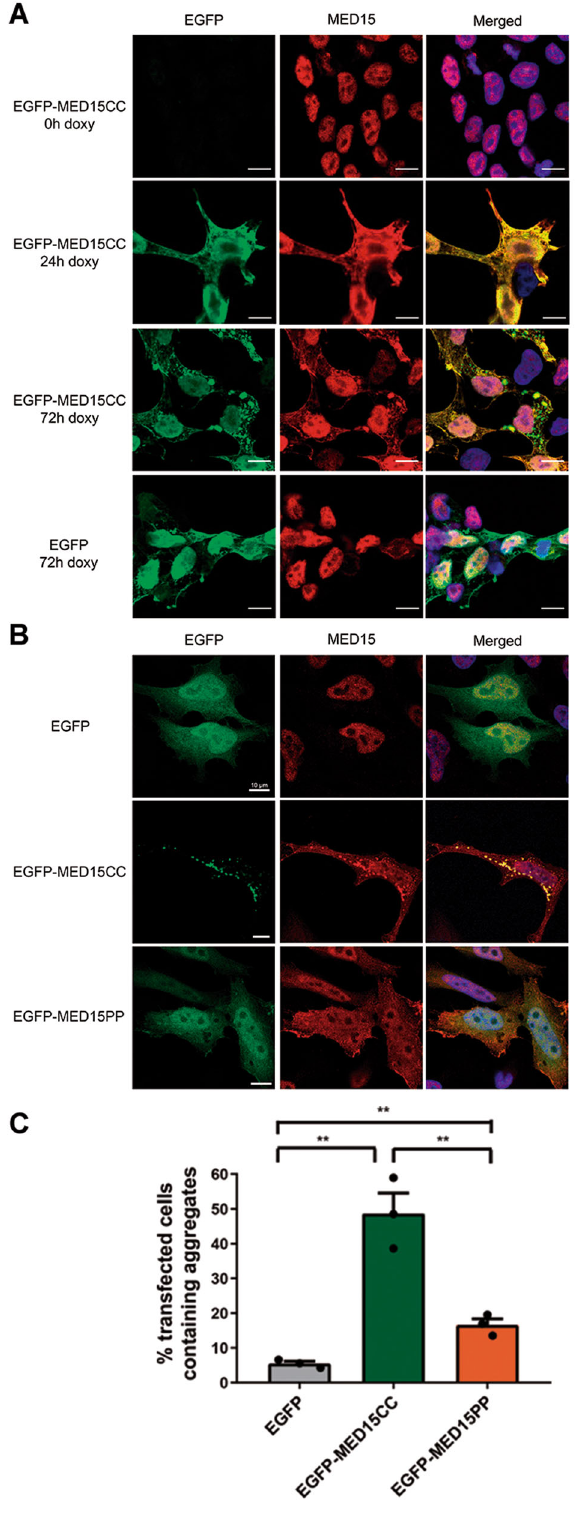
Fig. 6 MED15-PrLD forms insoluble cytoplasmic inclusions in mammalian cells. A Cellular localization by immuno fl uorescence of EGFP or EGFP- MED15CC in HEK293T cells after addition of doxycycline (doxy) for 0, 24, or 72 h. B Cellular localization by immuno fl uorescence of EGFP, EGFP- MED15CC, and EGFP-MED15PP in HeLa cells after expression for 24 h. In both A and B , cells were stained with MED15 antibody (red) to evaluate the effect of transfection in the endogenous mediator subunit, and with DAPI (blue) as nuclear marker. C Graph of percentage transfected cells containing cytoplasmic of perinuclear aggregates after EGFP, EGFP- MED15CC, and EGFP-MED15PP expression in HeLa cells. Dots represent the mean of